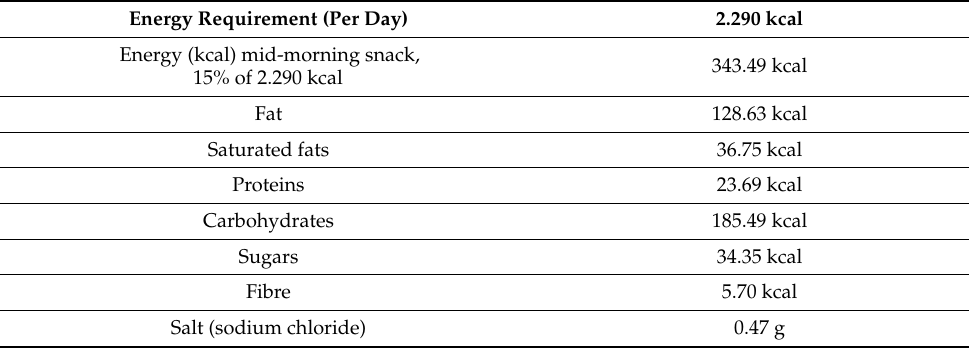
Table 2. Nutritional requirement for a mid-morning snack (15%) based on EFSA DRV